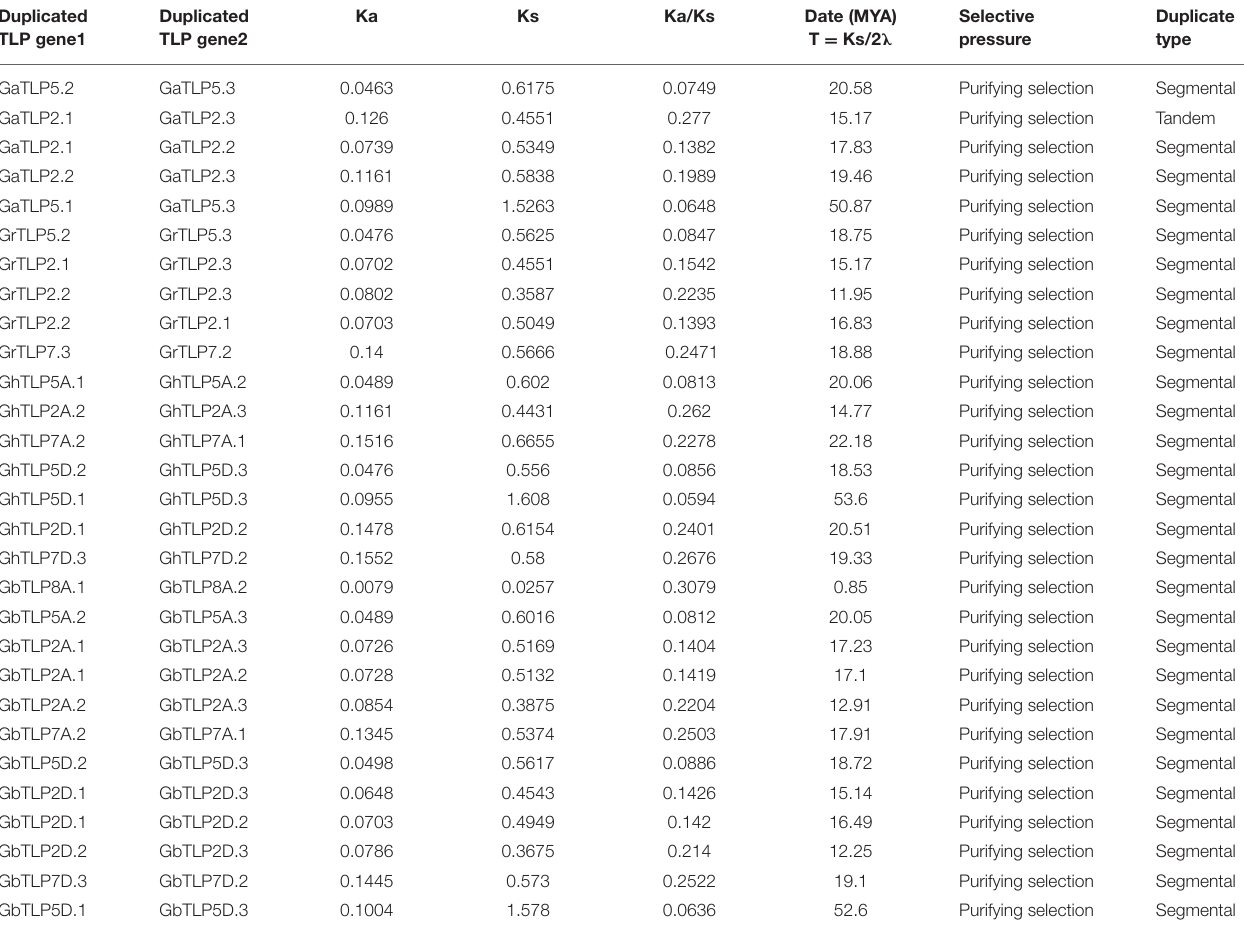
TABLE 2 | The date of duplication and Ka/Ks ratios for duplicate TLP genes in G. arboreum, G. raimondii, G. barbadense, and G. hirsutum . Duplicated TLP